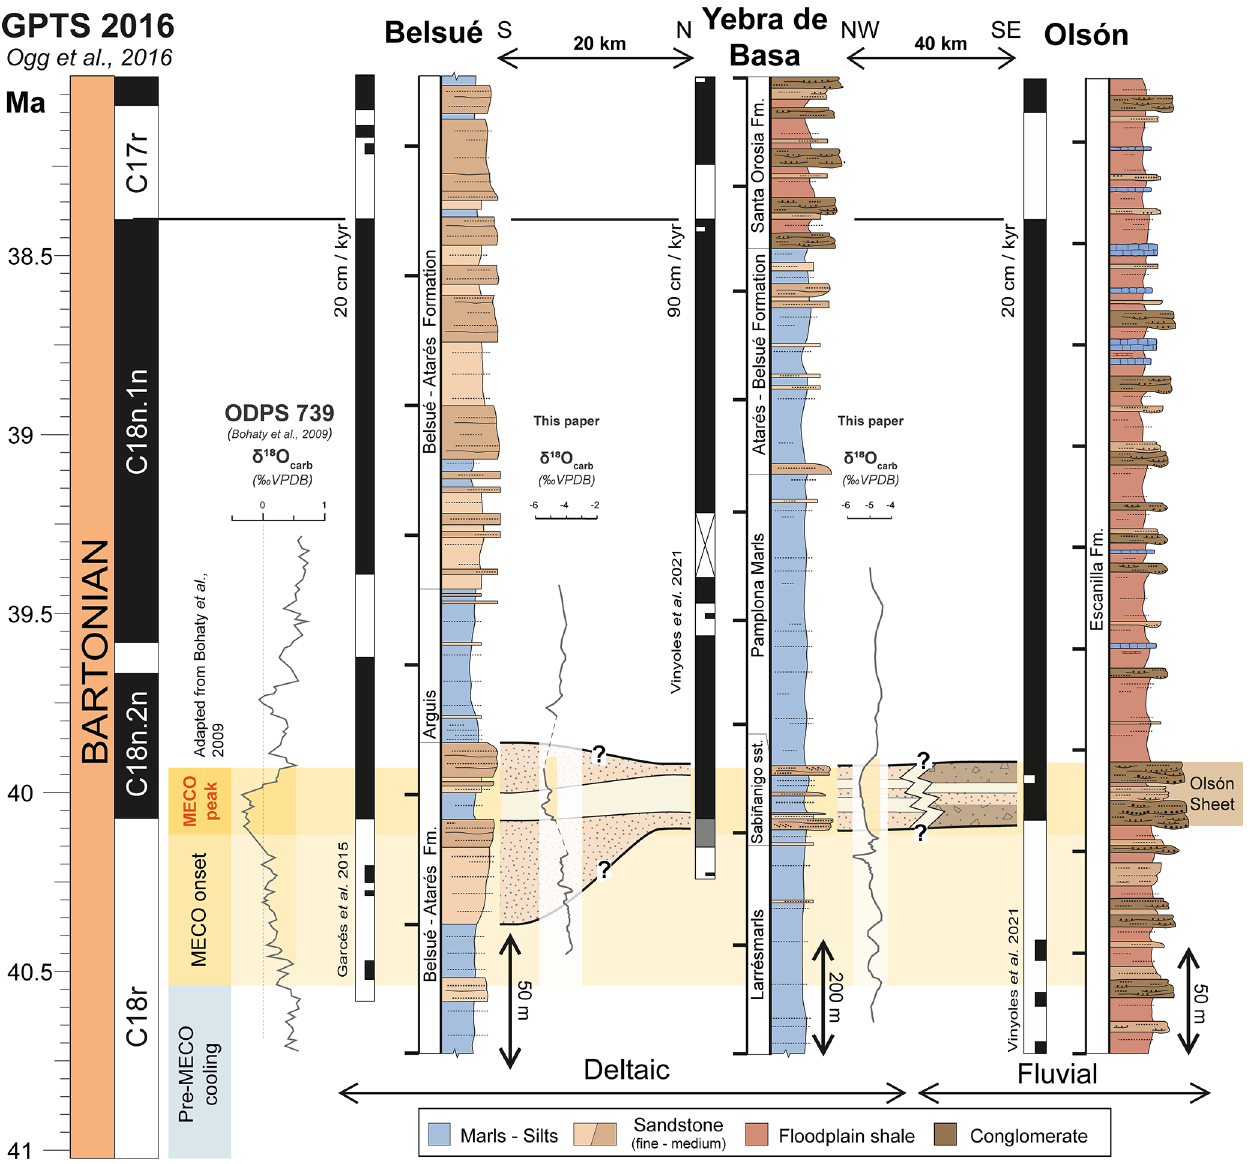
Figure 11. Correlation panel between Belsué, Yebra de Basa, and Olsón section with the GPTS 2016 (Ogg et al., 2016). The stratigraphic sections are modified from Garcés et al. (2014) and Vinyoles et al. (2021). The oxygen isotopic ( δ 18 O carb ) record from ODPS 738 and the MECO age constraints defined by yellow and blue bars are modified from Bohaty et al. (2009). The oxygen isotopic record ( δ 18 O carb ) from Belsué and Yebra de Basa corresponds to our results, and the dashed lines represent non-sample intervals. The sedimentation rates (SRs) from Belsué, Yebra de Basa, and Olsón are the average SR between chron C18n.2n and C17r, as from the data of Vinyoles et al.